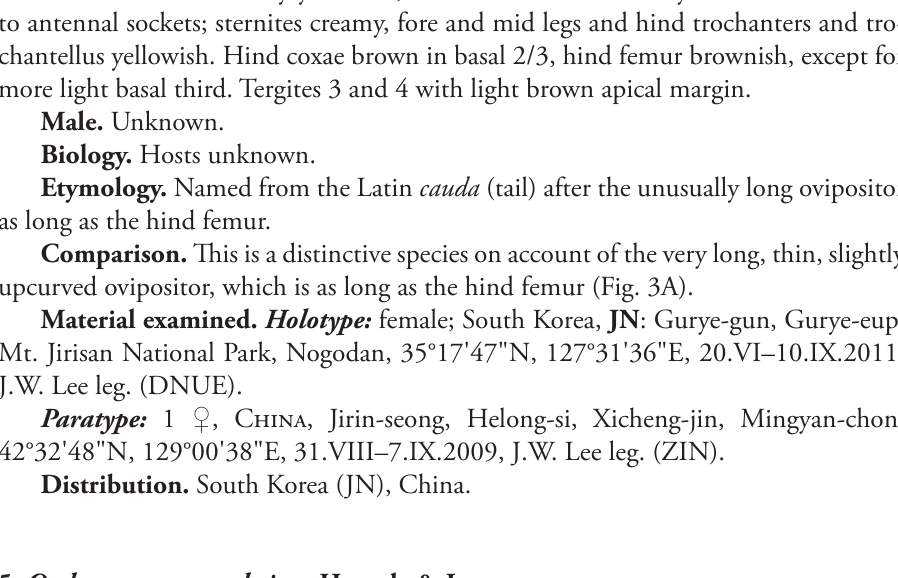
Description. Female. Fore wing length 4.0